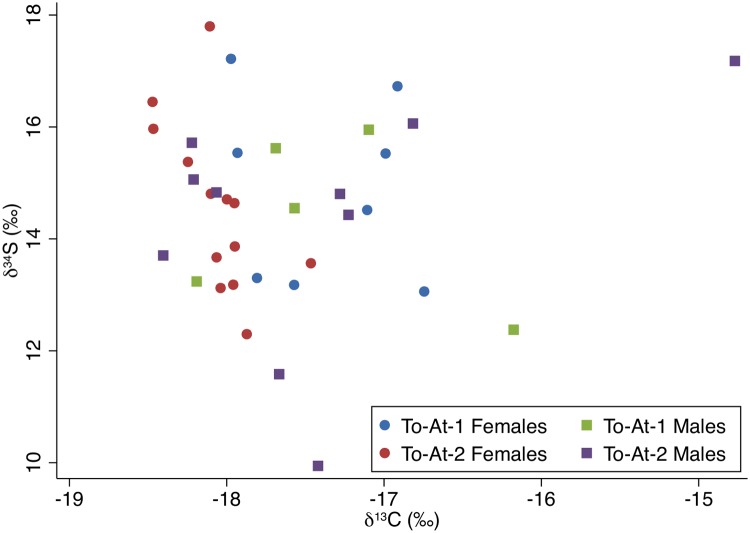
δ13C and δ34S values plotted by sex and burial mound.The δ34S outlier (To-At-2/27A) is labeled.